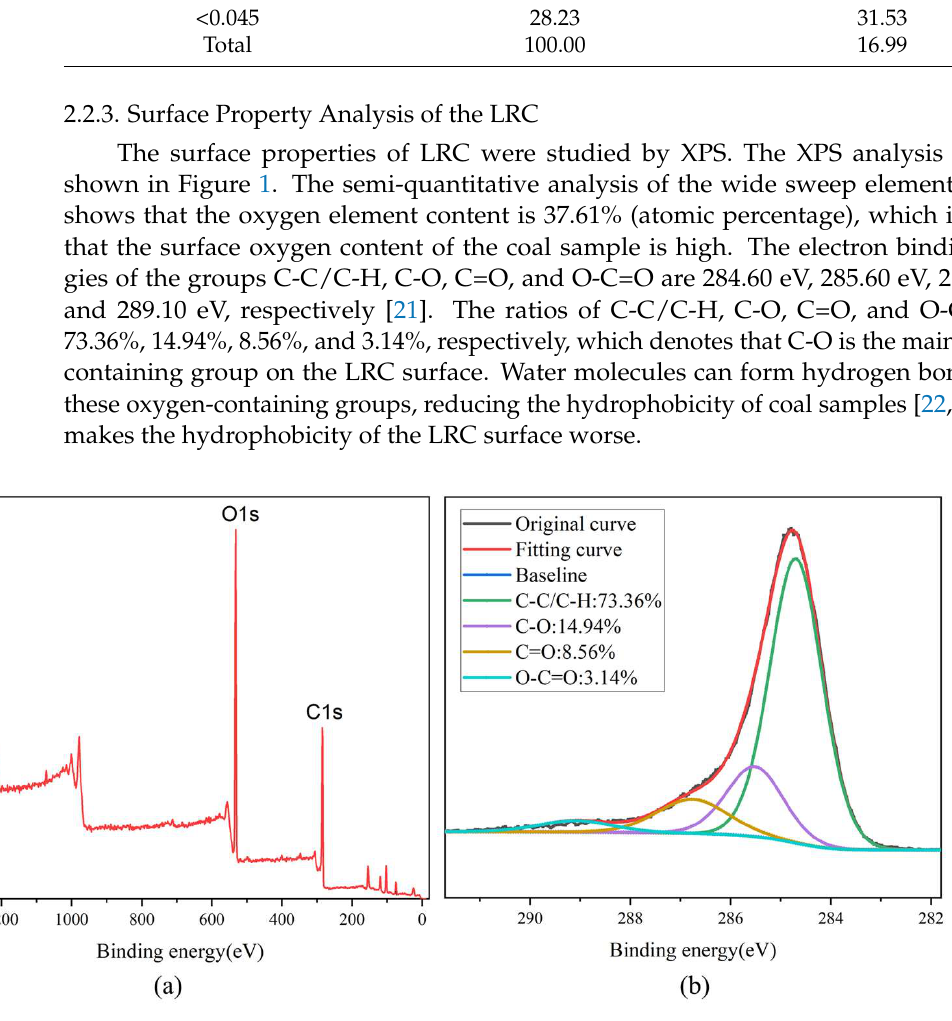
Figure 1. ( a ) XPS wide sweep spectra of the LRC sample, ( b ) C1s peak of the LRC sample.